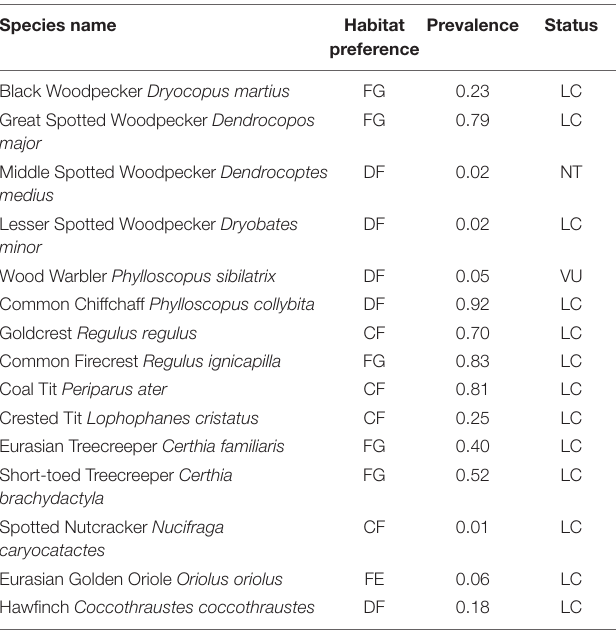
TABLE 1 | List if forest bird species studied; respective habitat preference (FG, Forest generalist; DF, Deciduous forests; CF, Coniferous forests; FE, Forest edges); prevalence in the study region and conservation status in Switzerland (Keller et al., 2010; Knaus et al., 2021): LC, Least Concern; NT, Near Threatened; VU,